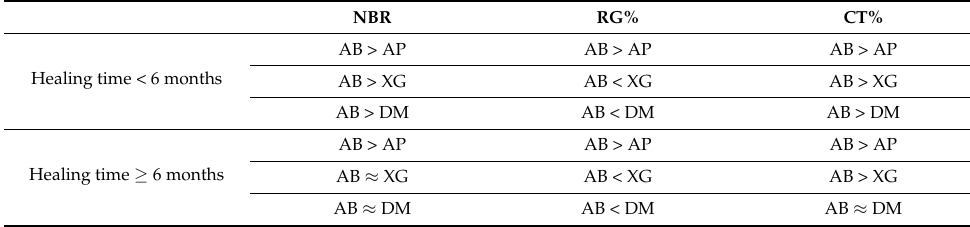
Table 6. Comparative summary of the healing characteristics of the bone substitutes (AB: autogenous bone; AP: alloplastic graft; XG: xenografts; DM: dentin matrix; NBR: New Bone Regeneration; RG: Residual Grafts; CT: Connective